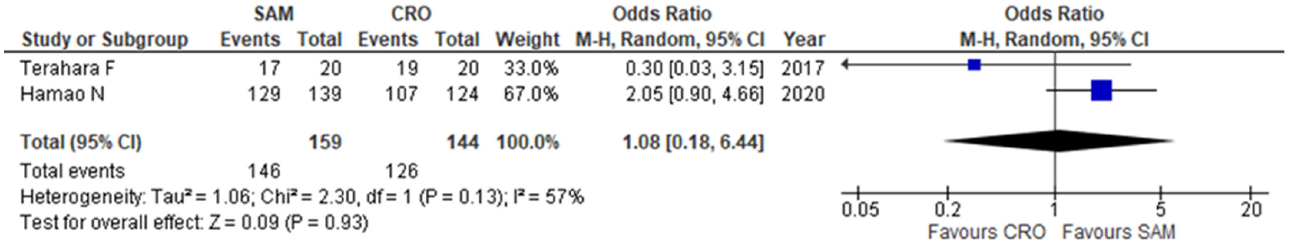
Figure 3. Forest plot presenting the odds ratios for clinical cure rates between sulbactam-ampicillin and ceftriaxone in community-acquired pneumonia. CI, confidence interval; CRO, ceftriaxone; M– H, Mantel–Haenszel; SAM, sulbactam-ampicillin; blue square, OR of each study; black rhombus, pooled OR.